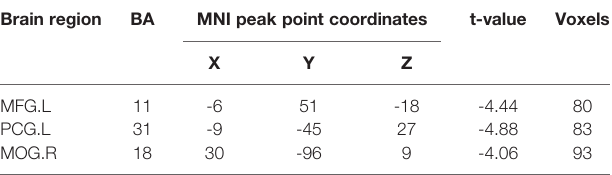
TABLE 2 | ALFF alterations between the two groups.